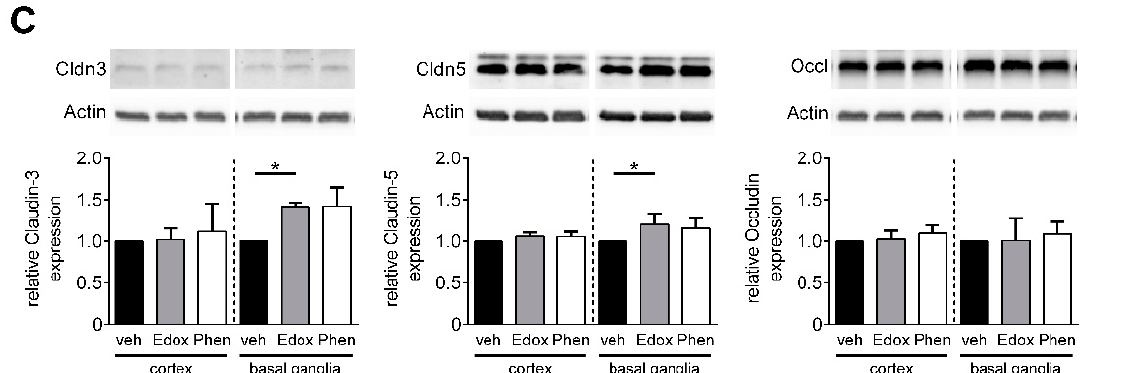
Figure 2. Edoxaban treatment stabilizes the blood–brain barrier and leads to anti-edematous effects in ischemic stroke. ( A ) Left : Representative corresponding coronal brain sections of vehicle (veh)-, edoxaban (Edox)- or phenprocoumon (Phen)-treated mice after the injection of the vascular tracer Evans Blue. Brains were analyzed at day 1 after transient middle cerebral artery occlusion (tMCAO) (Scale bar = 10 mm). Vascular leakage was decreased in the cortical and subcortical areas after edoxaban treatment. Right : Tissue concentration of Evans Blue in the ischemic (ipsilateral) and contralateral hemispheres of vehicle-, edoxaban-, or phenprocoumon-treated mice 24 h after tMCAO determined by photometry ( n = 5–8). ( B ) Edema formation as measured by brain water content in the ipsilateral and contralateral hemispheres of vehicle-, edoxaban-, or phenprocoumon-treated mice 24 h after tMCAO ( n = 4–6). ( C ) Top : Claudin (Cldn)-3, -5 and Occludin (Occl) protein expression in the ischemic cortices and basal ganglia of vehicle-, edoxaban-, or phenprocoumon-treated mice at day 1 after tMCAO as determined by immunoblot. Actin was used as loading control. Bottom : Densitometric quantification of Cldn-3, -5 and Occl immunoreactivity in the ipsilateral cortex and basal ganglia of vehicle-, edoxaban-, or phenprocoumon-treated mice ( n = 4). * p < 0.05.